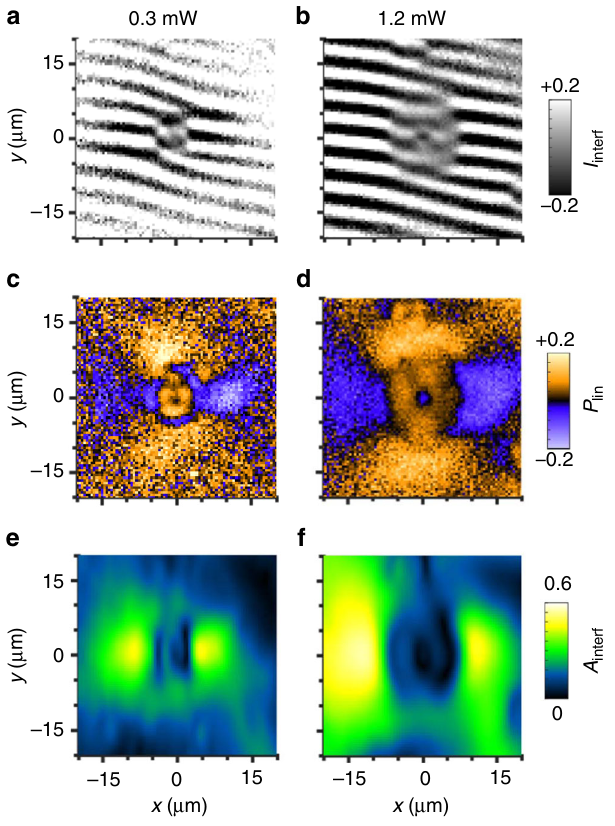
Fig. 2 IX coherence and polarization patterns vs power. a , b Shift- interference pattern of IX emission. δ x = 2 μ m. c , d The linear polarization of IX emission. e , f Amplitude of interference fringes in a , b . P = 0.3 (1.2) mW for left (right). T bath = 0.1 K. The data correspond to LBS 1 The phase shifts are sharp in the circular region around each LBS. However smoother phase shifts can be followed further (as shown by dashed magenta lines in Fig. 1b). The lines embracing the phase domains of interference fringes end by left- and right- forks of interference fringes at the opposite ends of the domain (the forks are shown by circles in Fig. 1b), indicating that the forks originate from the phase domains.